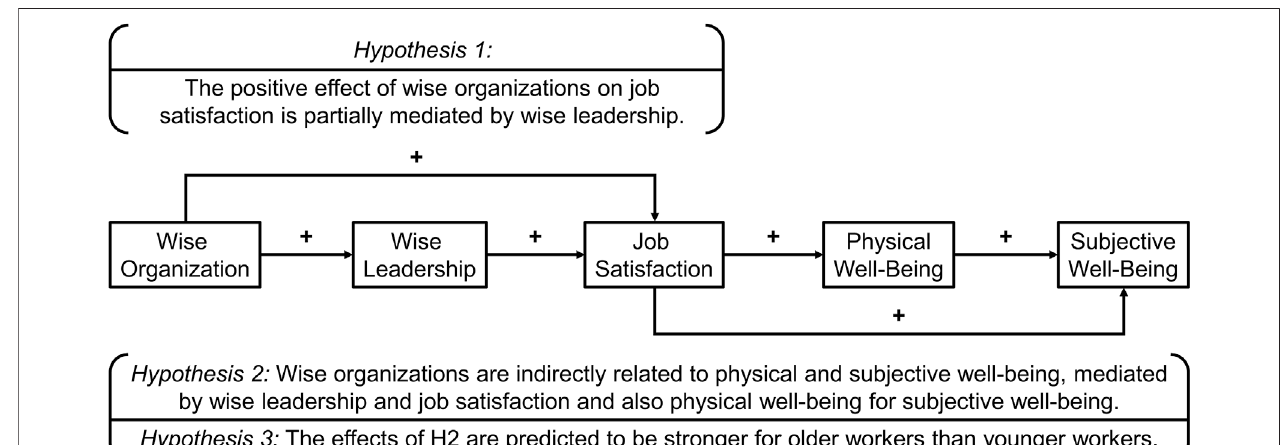
FIGURE 1 | Theoretical model with